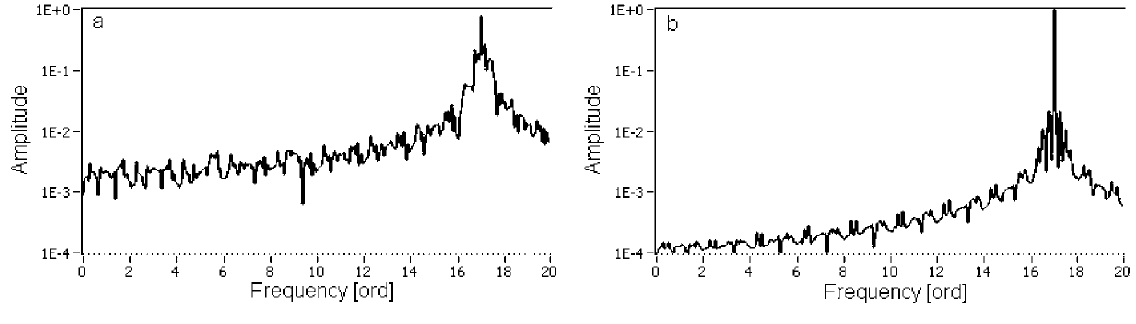
Fig. 8. Order spectrum of a 17 ord